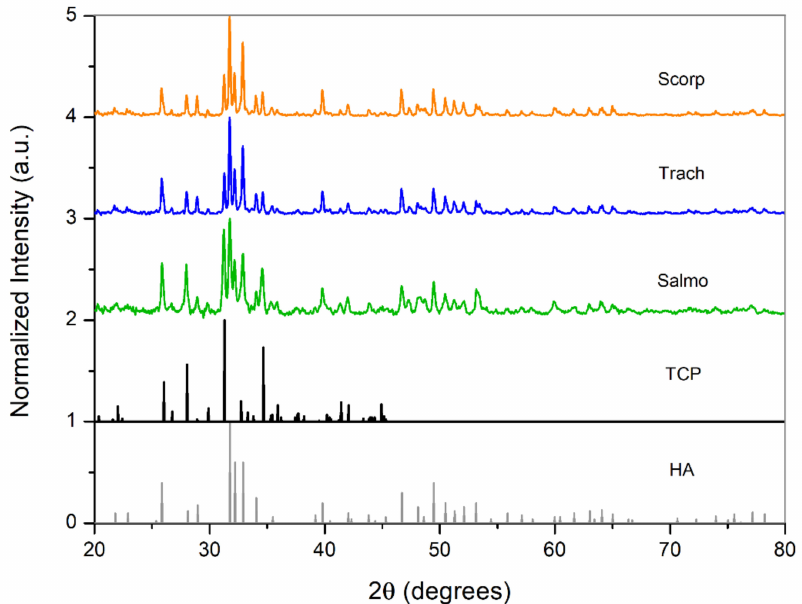
Figure 6. X-ray powder diffraction (XRD) patterns of material thermally treated at 750 ◦ C compared with stoichiometric HA and